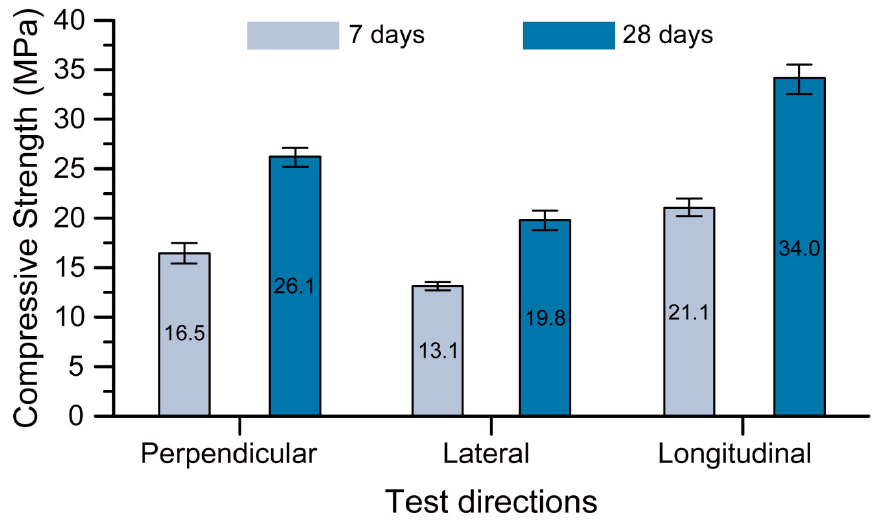
Figure 11. Compressive strength of Na-N-2.5 (the optimum 3D printable mixture) in different directions.